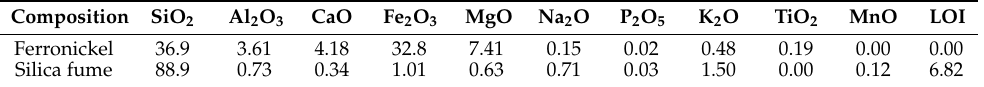
Table 1. Ferronickel slag and silica fume chemical analysis through XRF (Mass/%) *. Composition SiO 2